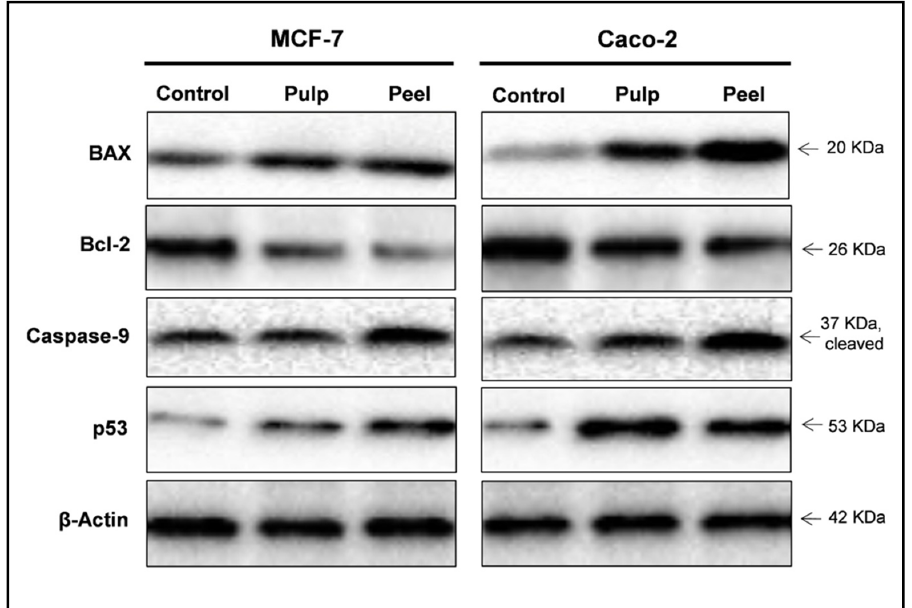
Figure 4. The immunoblotting images for the expression levels of BAX, Bcl-2, cleaved caspase-9, and p53 proteins, with β -actin as loading control. Representative Western blot images show the effects of the pitaya pulp and peel extracts on the expression levels of BAX, Bcl-2, caspase-9, and p53 proteins in MCF-7 and Caco-2 cells .